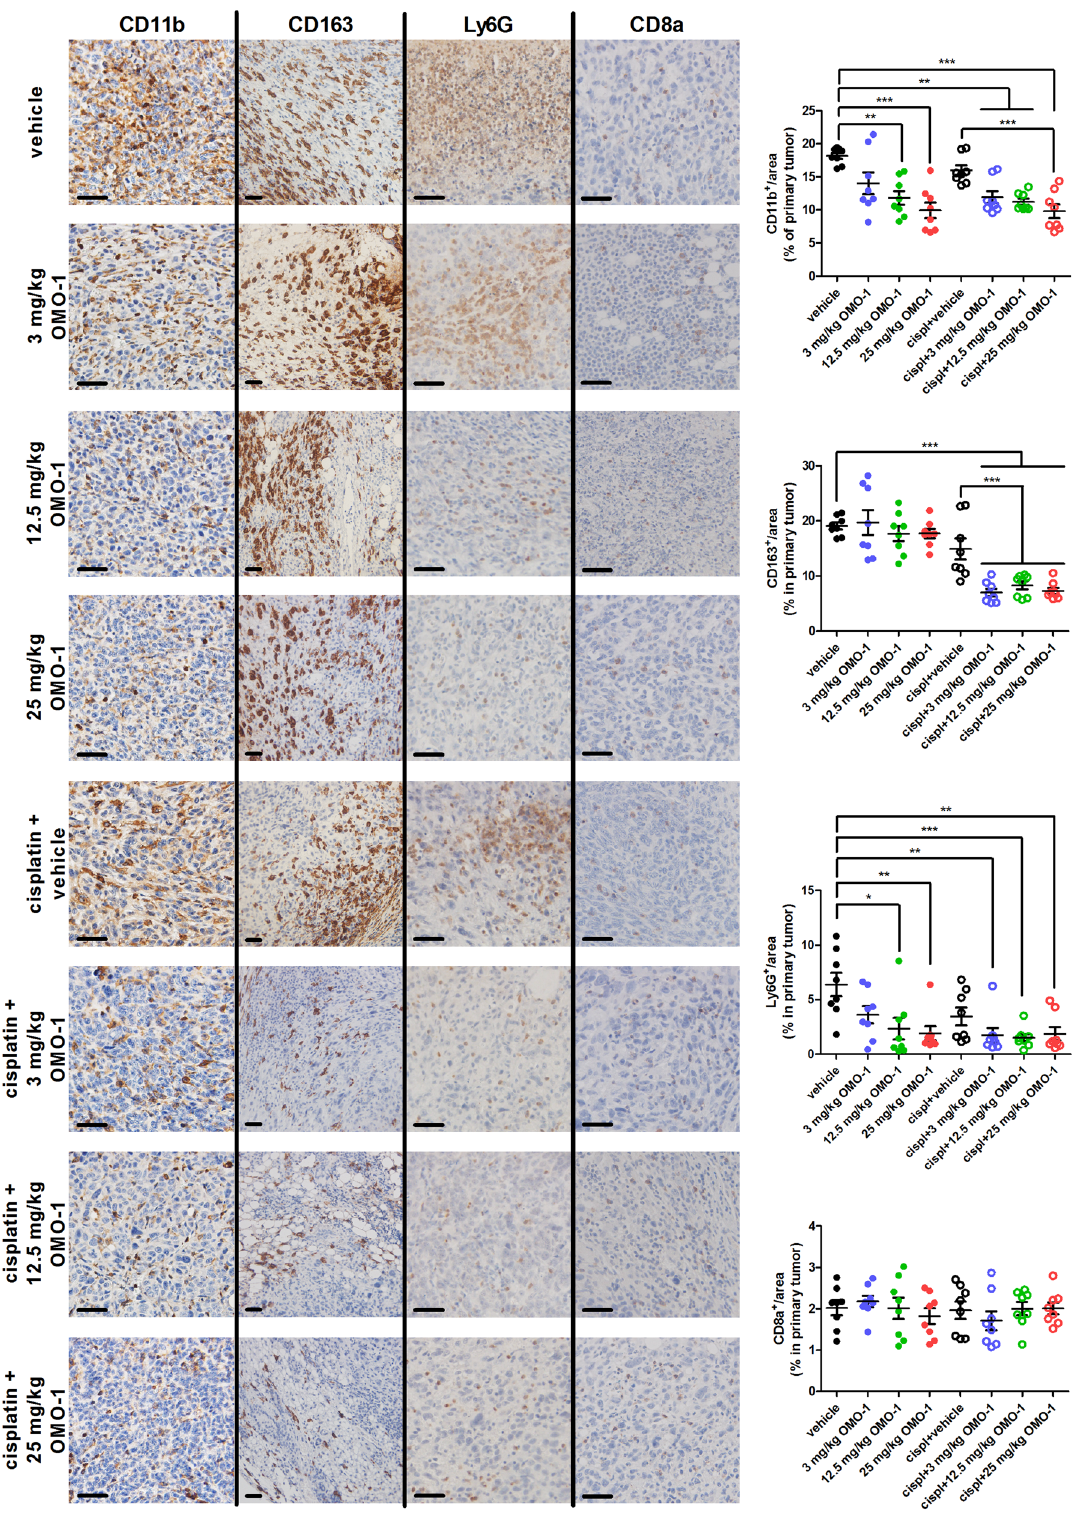
Fig. 2 OMO-1 impacts tumor in fi ltrating neutrophils and immunosuppressive macrophages in a 4T1-based intraductal model. Immunohistochemistry for CD11b (pan-myeloid cells), CD163 (tumor-associated macrophages), Ly6G (neutrophils), and CD8a (cytotoxic T-cells) on paraf fi n sections of primary tumors from the different treatment groups at 39 days p.i. ( n = 8; 2 slides per treatment group for each marker with 4 images per slide). Scale bars = 50 µm. Data are presented as the means ± SEM. * P < 0.05, ** P < 0.01, *** P <